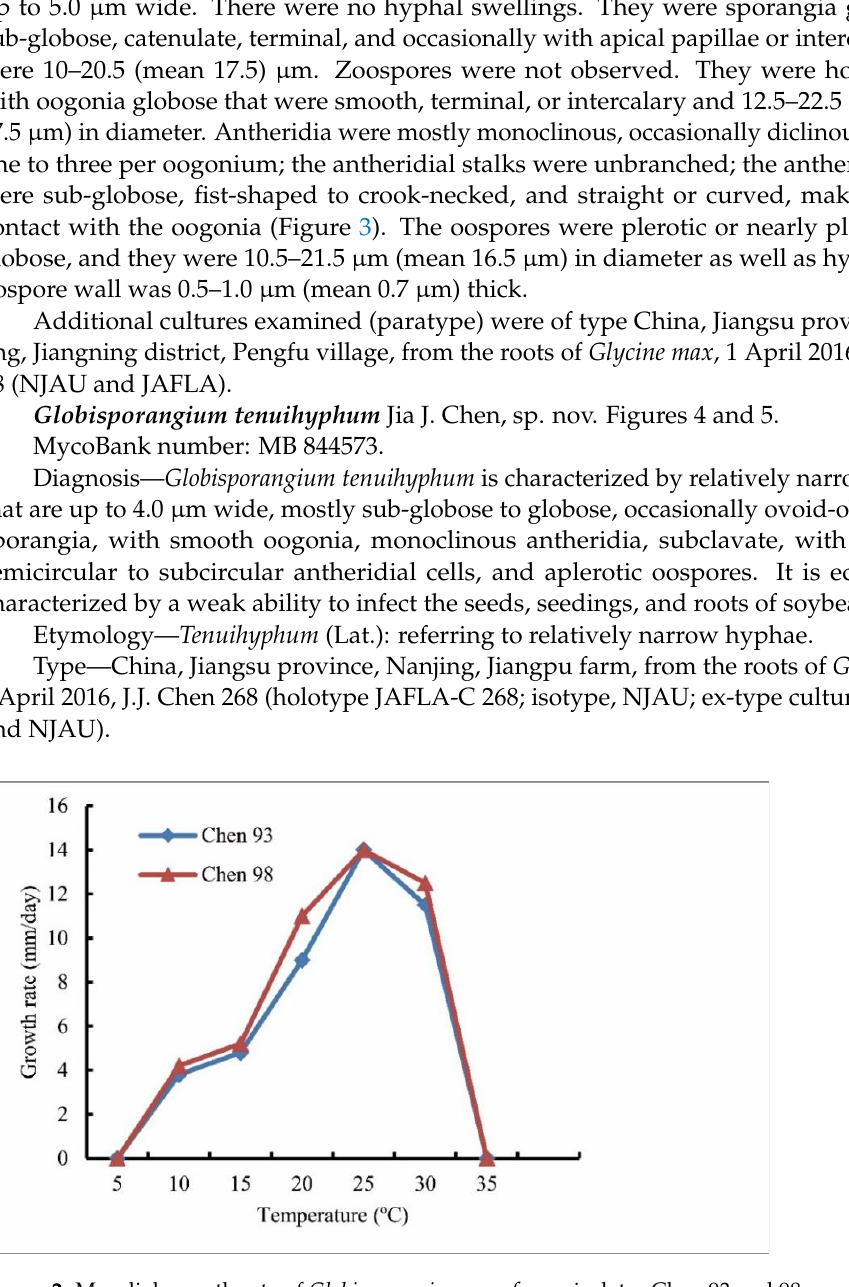
Figure 2. Mycelial growth rate of Globisporangium pengfuense isolates Chen 93 and 98 on potato carrot agar at different temperatures.